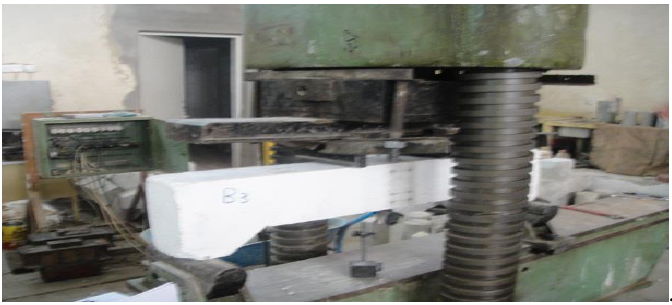
Figure 16. Positions of the dial gauges in the previous test [23]. Reprinted from Ref.